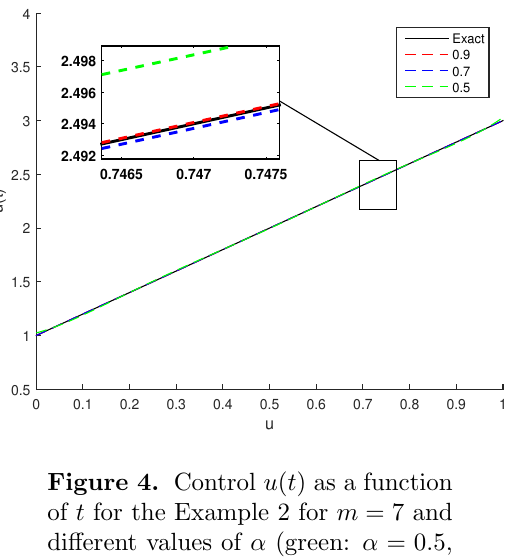
Figure 4. Control u ( t ) as a function of t for the Example 2 for m = 7 and different values of α (green: α = 0 . 5, blue: α = 0 . 7, red: α = 0 .